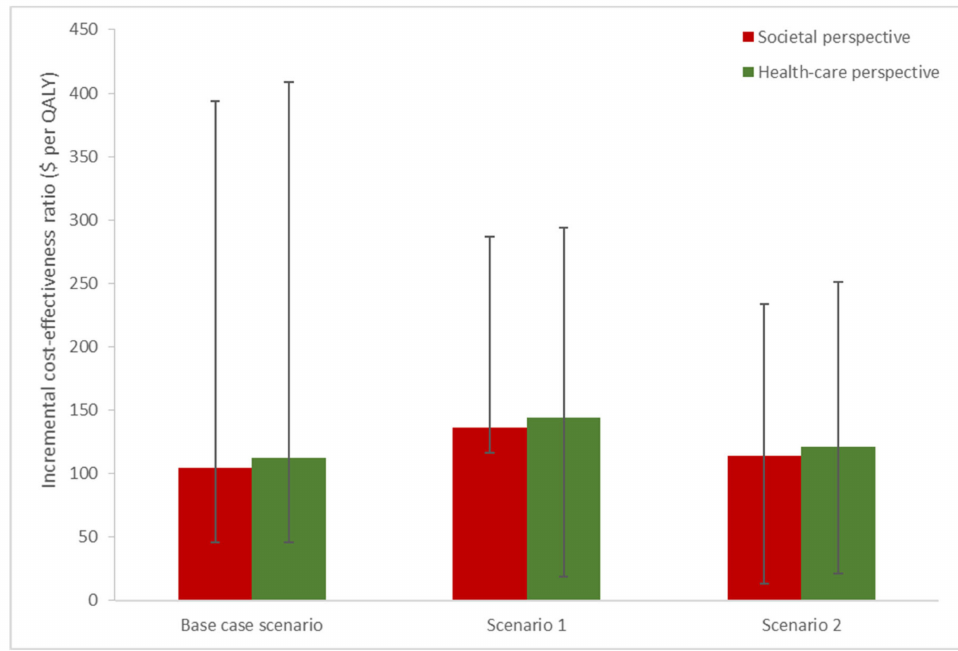
Figure 3. The incremental cost-e ff ectiveness ratios (ICERs) of vaccination strategies compared with a no-vaccination strategy. The bar heights show the ICERs for a base assumption of 71% vaccine e ff ectiveness against TB, and the error bars indicate the lower (42%) and upper (85%) ranges of cost-e ff ectiveness. Three di ff erent waning protection scenarios were applied: protection for the first 10 years (base case), a linear waning e ff ect of 20 years (scenario 1), and an exponential waning e ff ect (scenario 2). Red and green bars show the societal and health-care perspective,